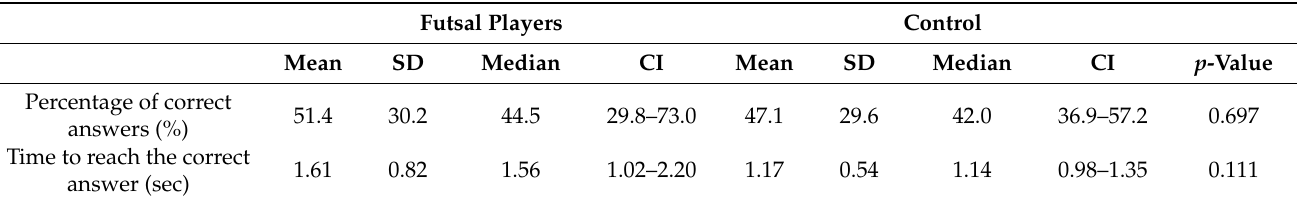
Table 5. Results of the reaction capacity